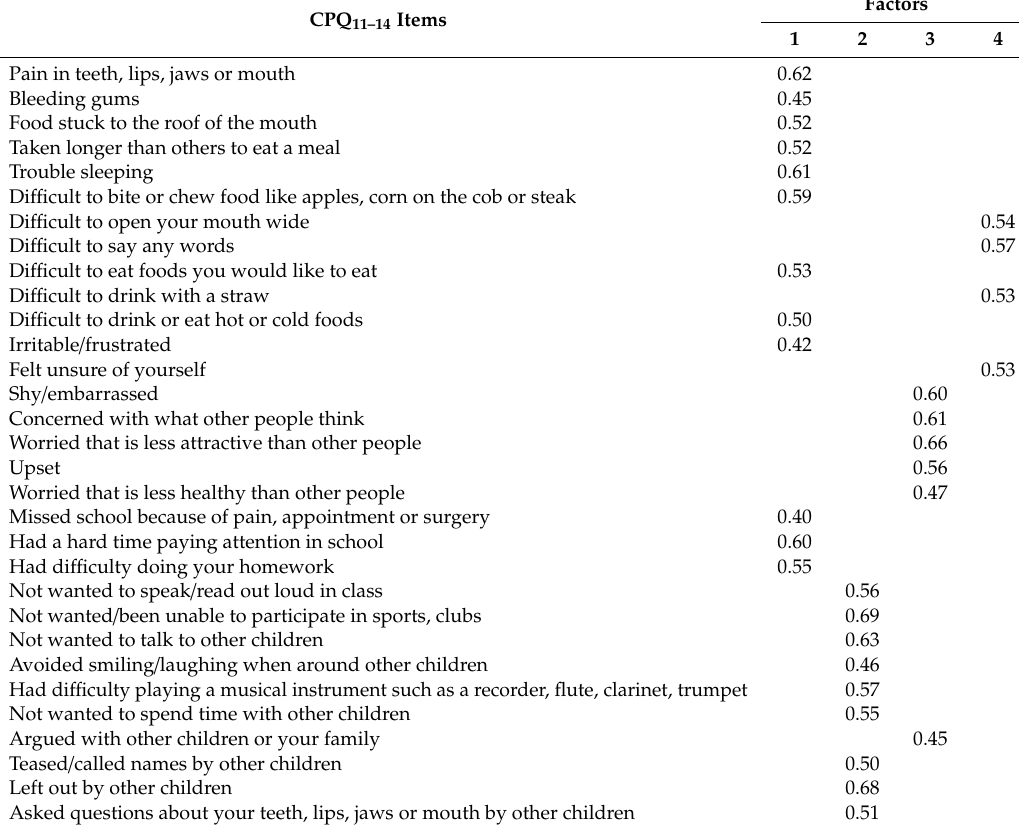
Table 1. Factor loadings of the Hindi version of CPQ